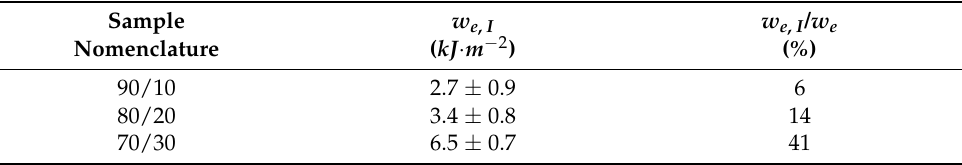
Table 5. Specific essential EWF parameter related to initiation along with the percentage ratio of initiation/global essential parameters of rPP/rPET-O calendered